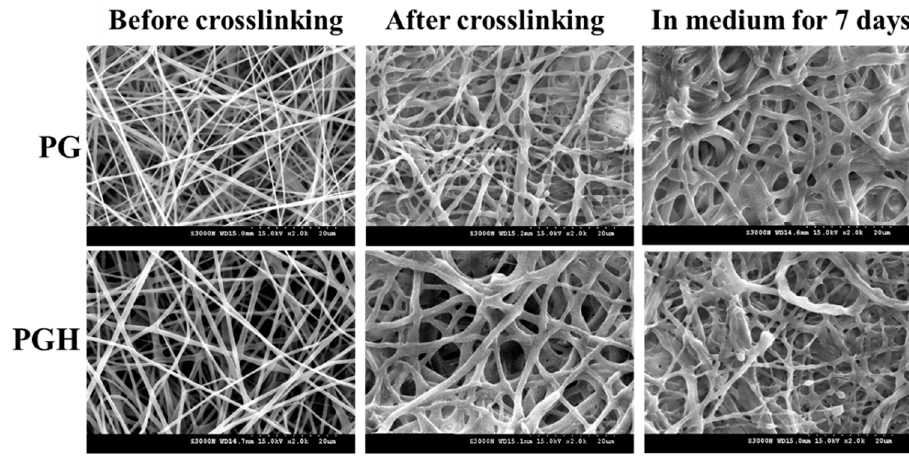
Figure 1. The scanning electron microscope (SEM) images of pristine and crosslinked PG and PGH fibrous membrane scaffold (FMS). The crosslinked FMS was immersed in cell culture medium for 7 days and examined by SEM for stability. Bar = 20 μ m.